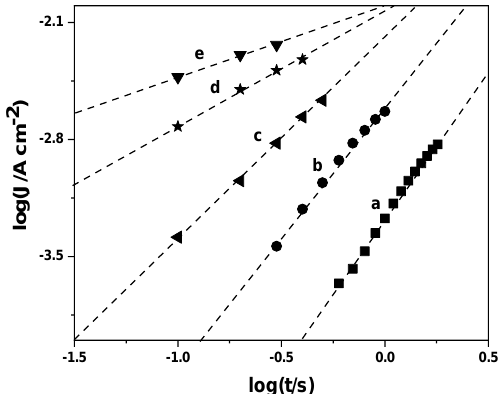
Figure 6. Double logarithmic plot of current vs. time for the rising part of the current transients recorded for Sn-rGO deposition from ILEG + 0.05 M SnCl 2 + 20 mg L − 1 GO. Various applied potentials: (a) −450 mV, (b) −470 mV, (c) −490 mV, (d) − 510 mV, (e) − 530 mV.